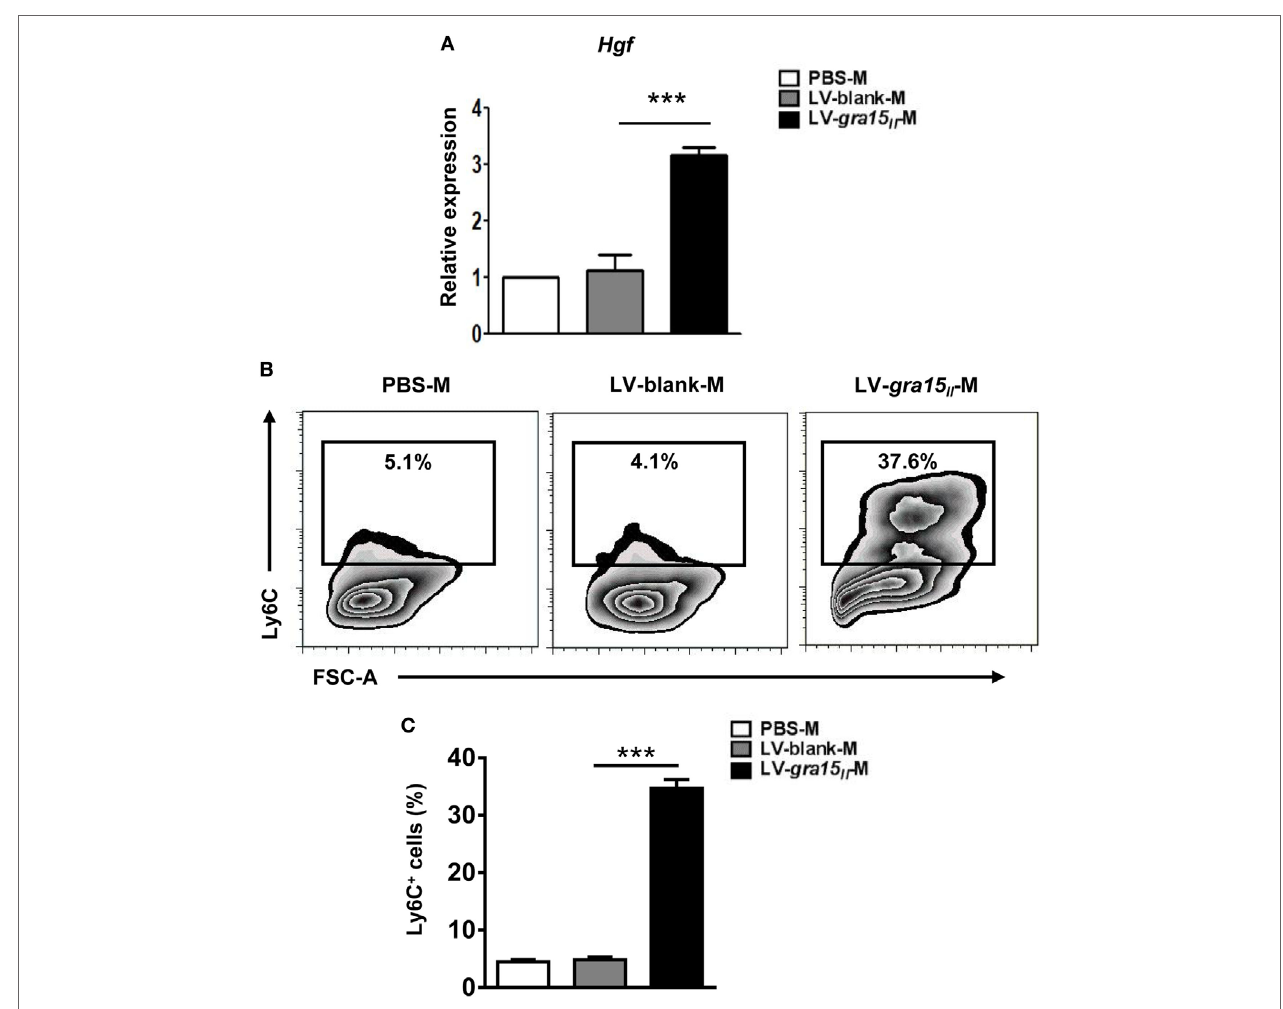
FigUre 8 | Lentiviral vector (LV)- gra15 II -M had high expression of hepatocyte growth factor (HGF) and lymphocyte antigen 6 complex (Ly6C). The liver macrophages were isolated, purified, and collected from mice. The liver macrophage RNA was extracted to analyze the expression of HGF by quantitative real-time PCR (a) . The expression of Ly6C on the LV- gra15 II -M surface was detected by FCM (B,c) . Data represent mean ± SD from multi-group experiments. *** p < 0.001 ( n = 4 each